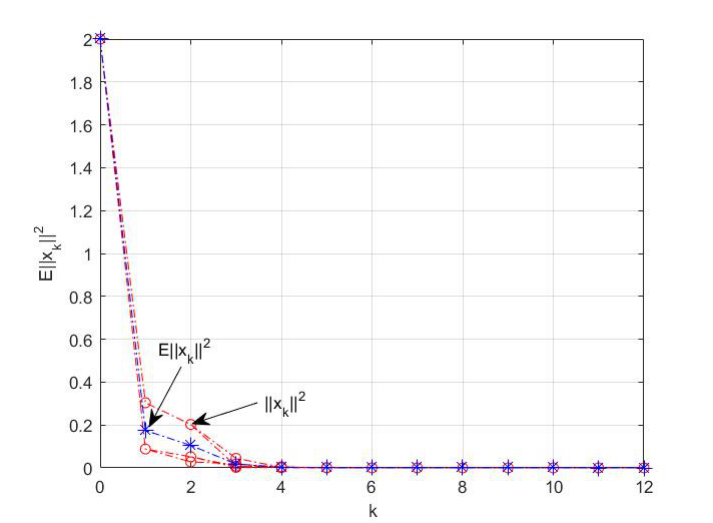
Figure 4. The norm E (cid:107) x k (cid:107) 2 curve of the closed-loop system state with respect to the iteration step k in Example